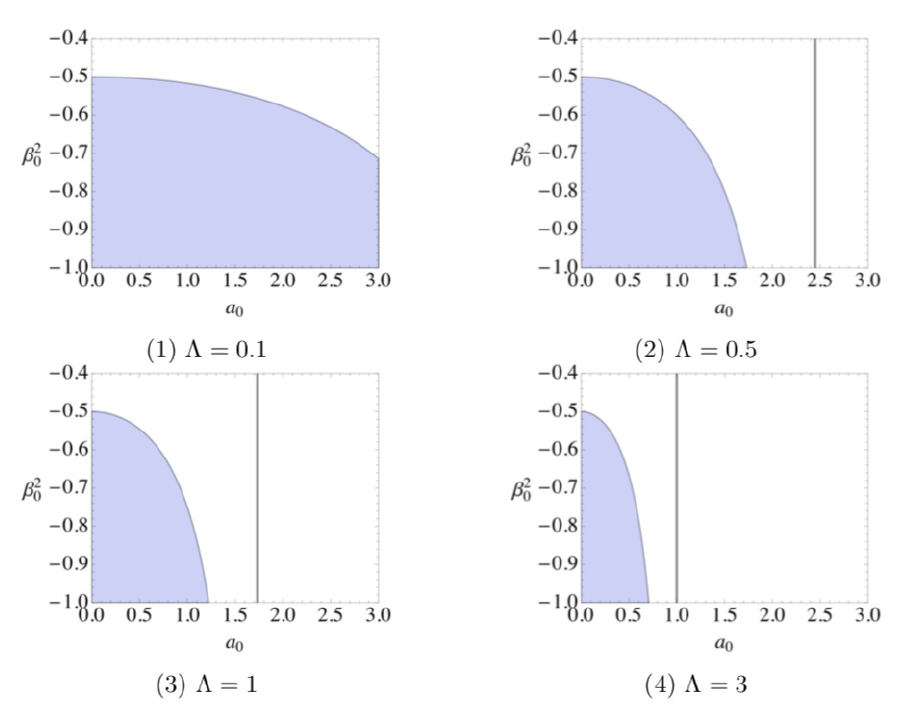
Figure 12. De-Sitter wormholes. A stable region is below the curve. Each vertical line represents the cosmological horizon. Hence, the right side of the vertical line is an unphysical region.